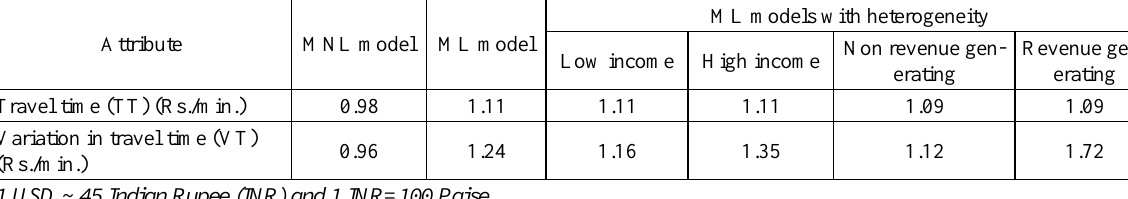
Table 6. Value of travel time and its variation for private car trip makers